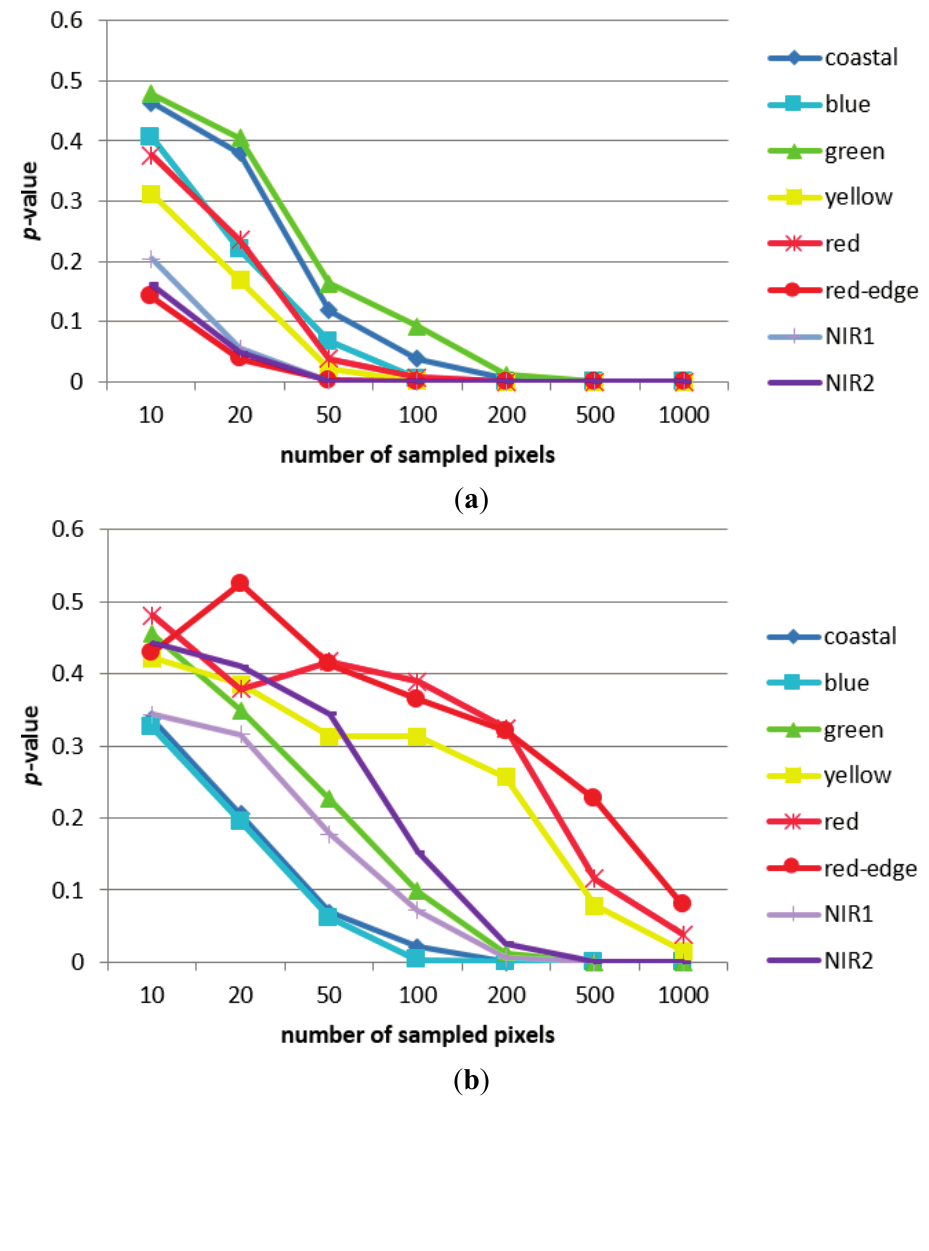
Figure 5. The per-band p -value computation between segments with similar land covers (two black roofs) when different sizes of sampled pixel sets were applied and when: ( a ) the two-sample Kolmogorov-Smirnov statistics; ( b ) the Student’s t -test statistics was